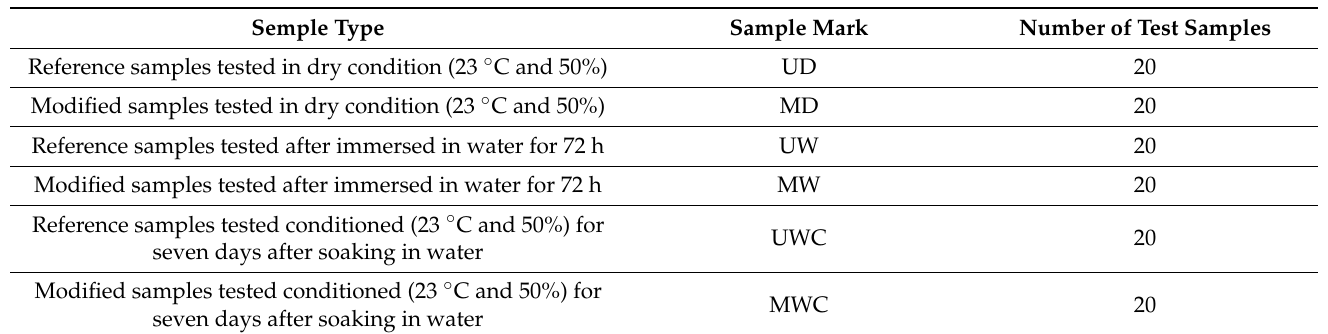
Figure 5. Shear test sample according to EN 205 [41]. Table 2. Investigation plan through testing